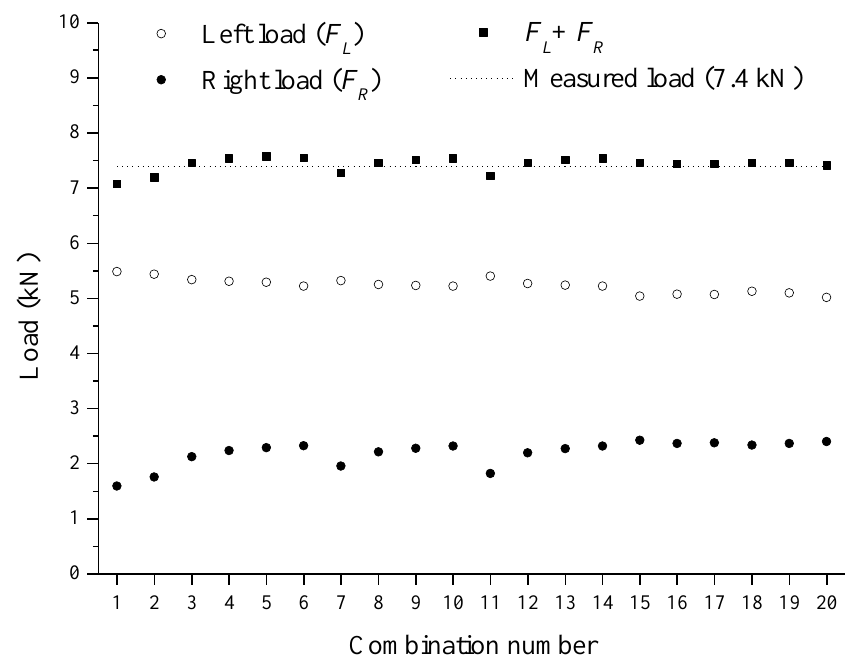
Figure 7. Identified loads according to 20 combinations (loading step